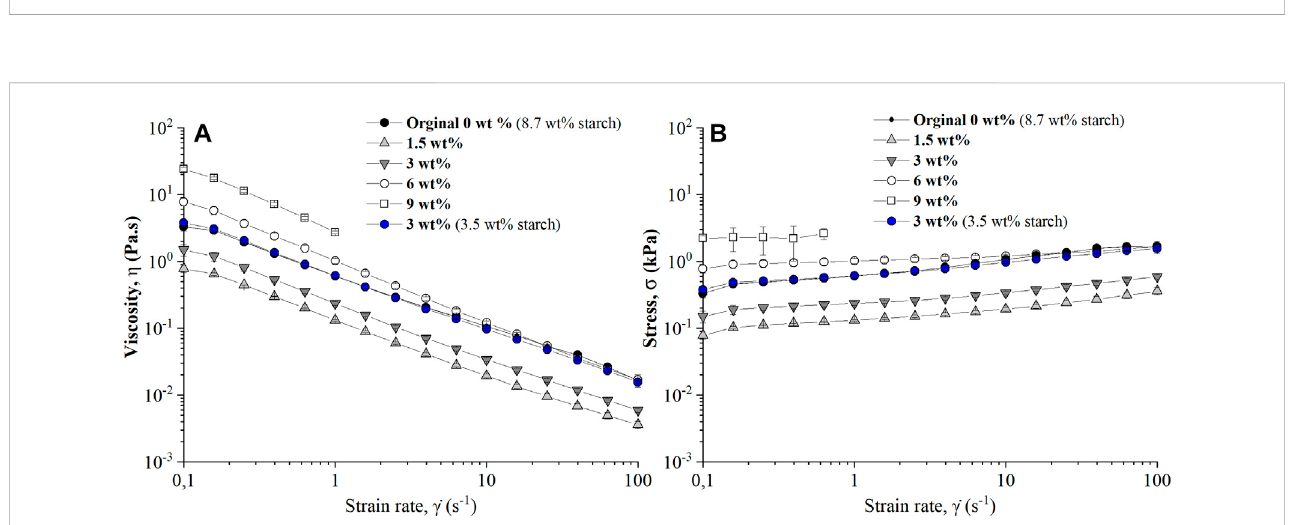
FIGURE 2 Flow curves of the different formulations (A) viscosity (Pa.s) vs. shear rate (1/s) and (B) Stress (kPa) vs. shear rate (1/s).